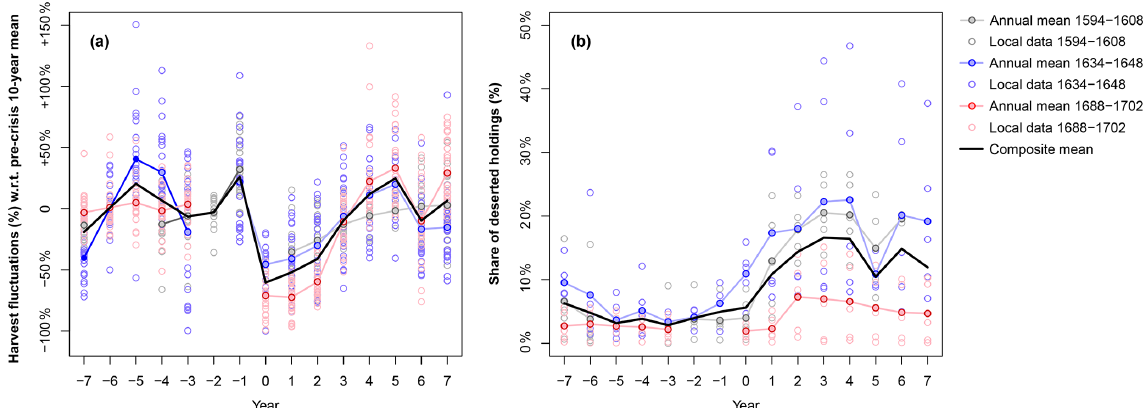
Figure 4. The 15-year segments of composite (a) grain tithe and (b) desertion data indicating the grain harvest and socioeconomic responses, respectively, centered on the 17th century years of peak global volcanic aerosol forcing (1601, 1641,